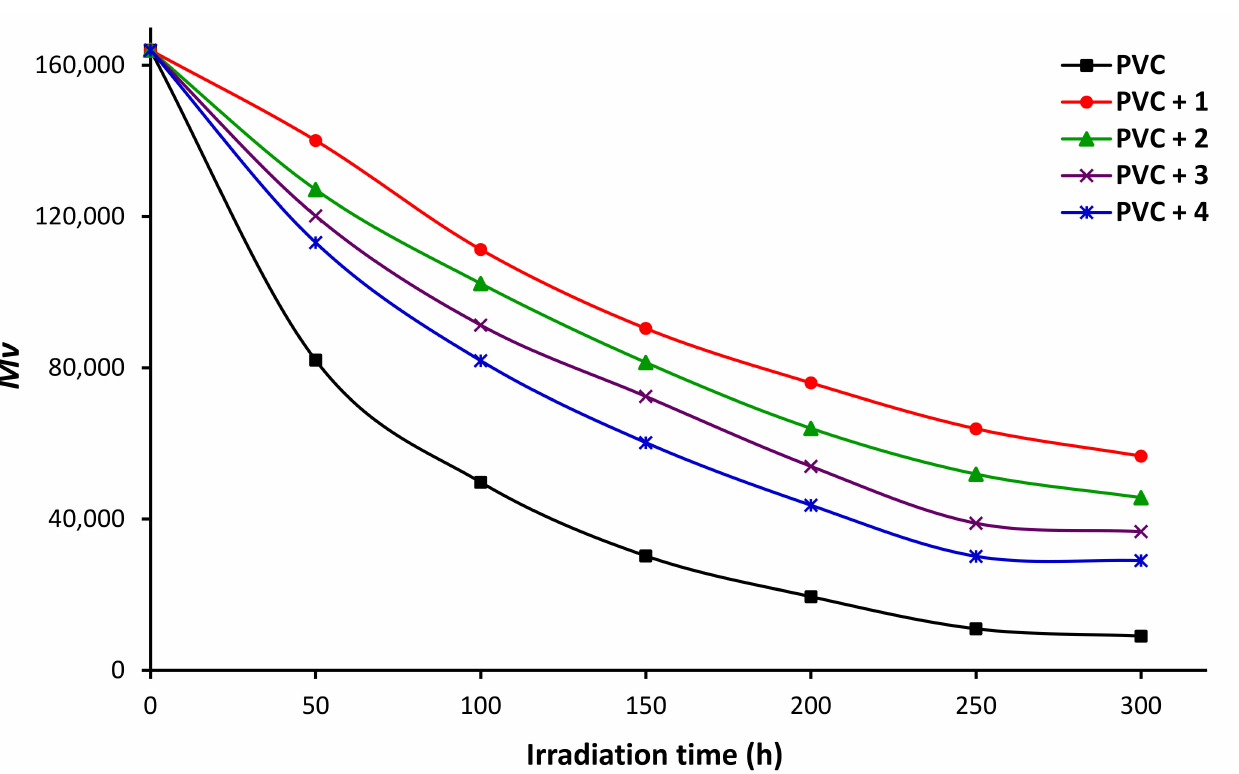
Figure 6. The molecular weight as a function of time during the irradiation of pure and tin-complex blended